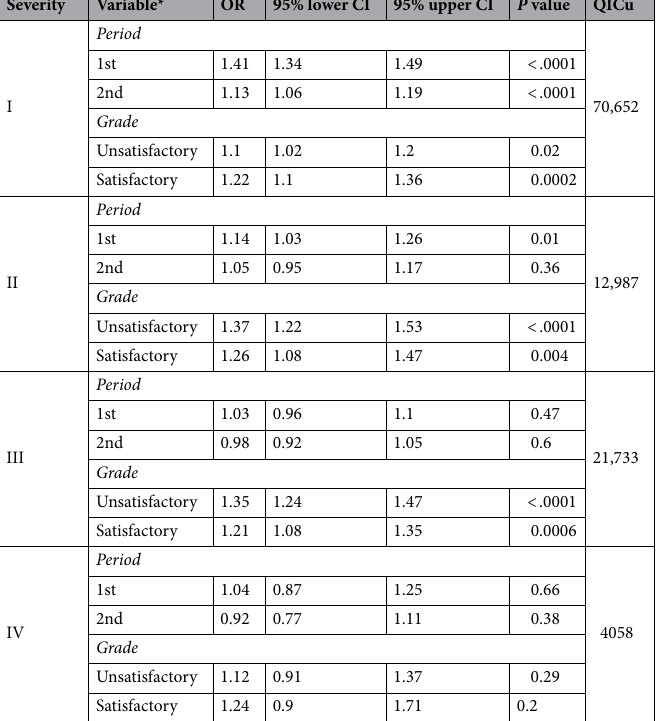
Table 5. OR and 95% confidence interval (CI) of covariates to exacerbation in subgroup model (QICu = 109,430). *Reference levels: 3rd for Period variable, tertiary for Grade